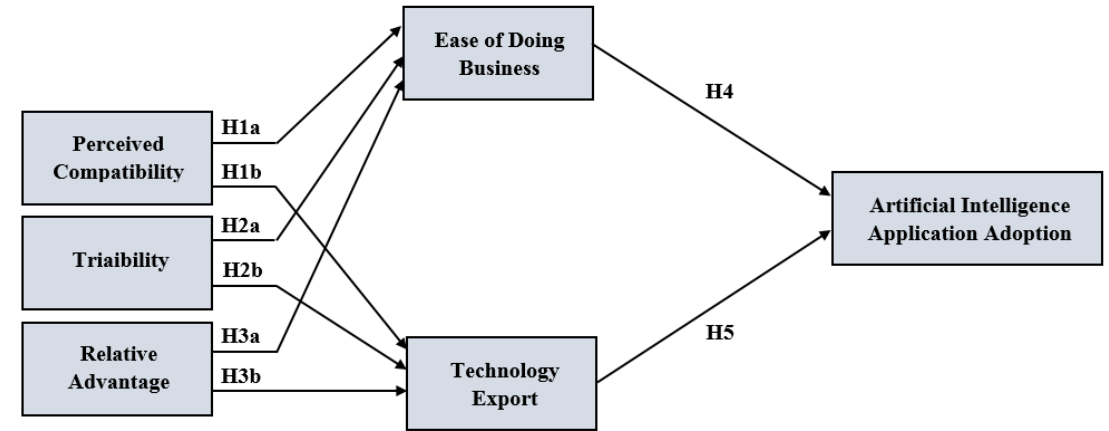
Fig. 1. Proposed research